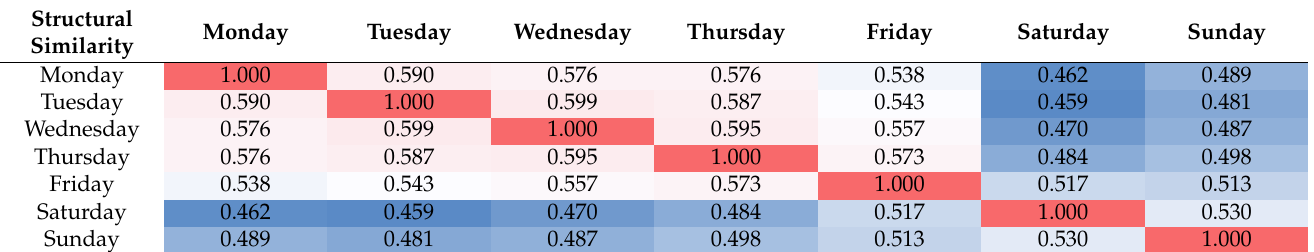
Table 6. Flow similarity of the OD matrixes in New York.